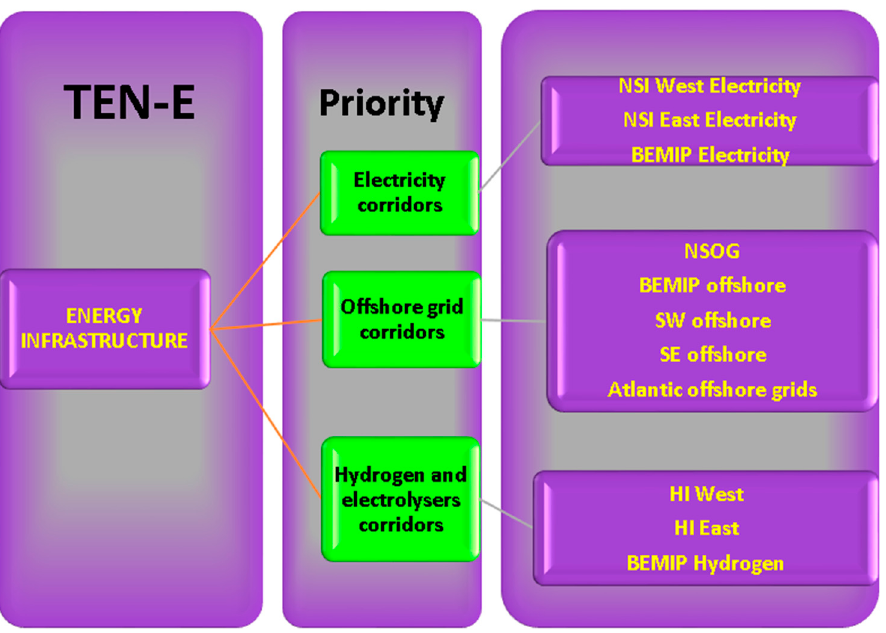
Figure 3. Energy infrastructure analysis using priority corridors.